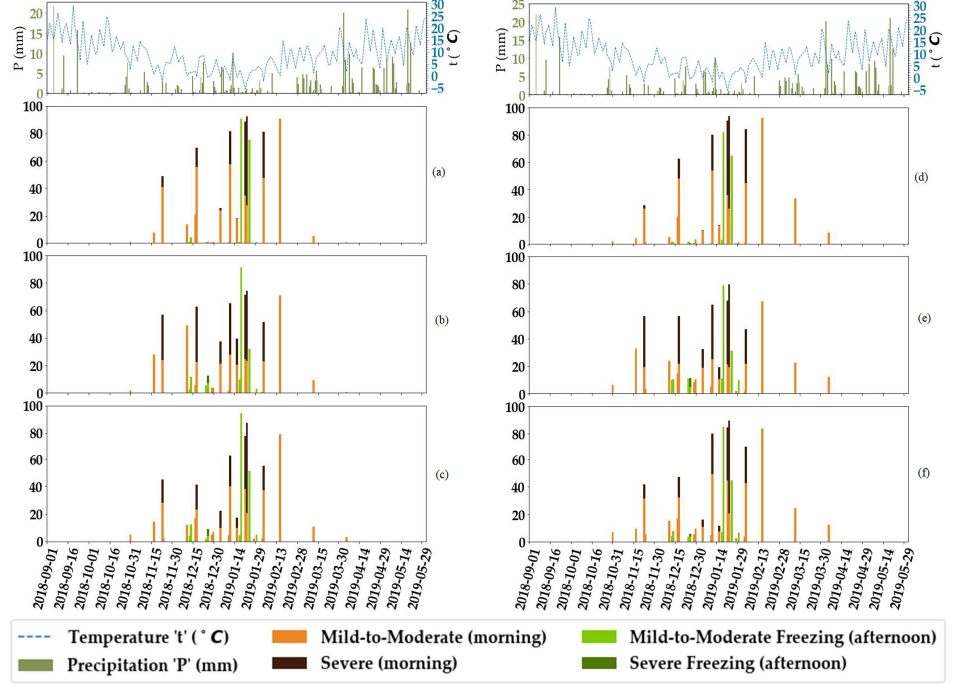
Figure 12. The distribution of mild-to-moderately and severely frozen plots in site B, for each S1 acquisition, and using VH and VV polarizations after applying the temperature filter. ( a ) VH-LC1, ( b ) VH-LC2, ( c ) VH-LC3, ( d ) VV-LC1, ( e ) VV-LC2, ( f ) VV-LC3. Precipitation (P) and temperature (t) are given in the graph at the top.